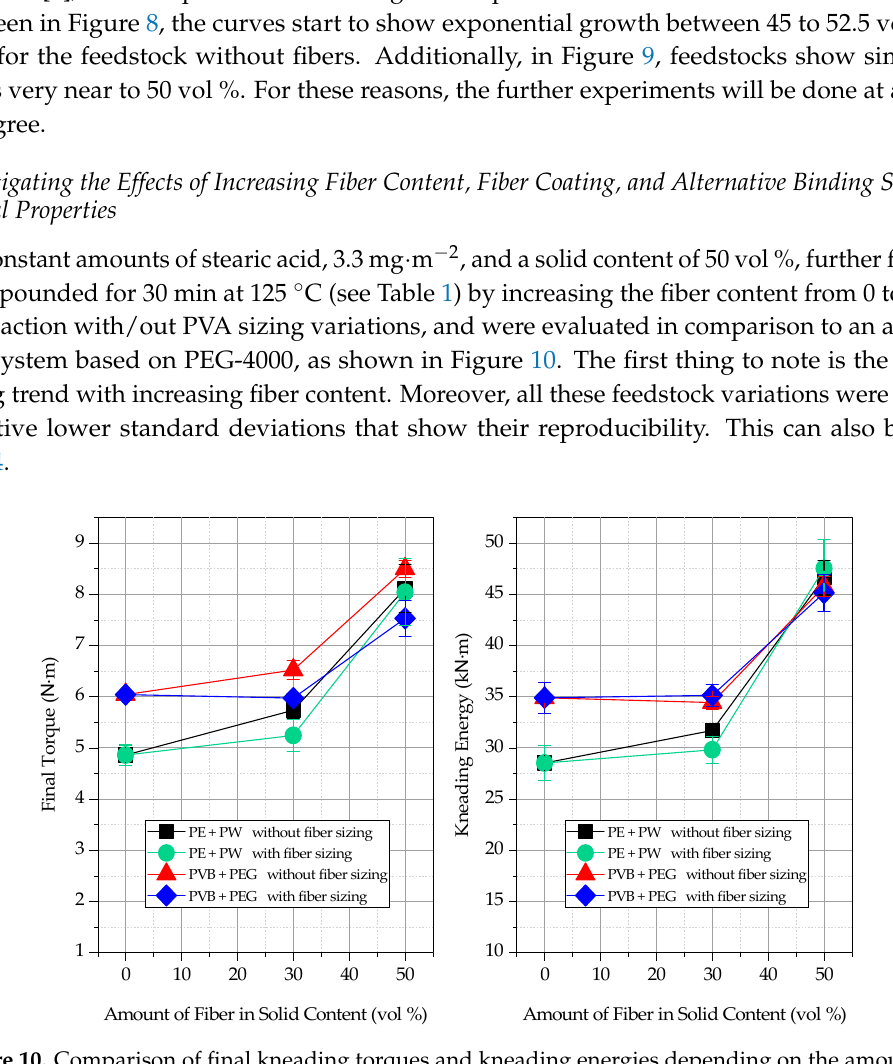
Figure 10. Comparison of final kneading torques and kneading energies depending on the amount of fibers in solid content, the presence of PVA sizing, and the binding system used.